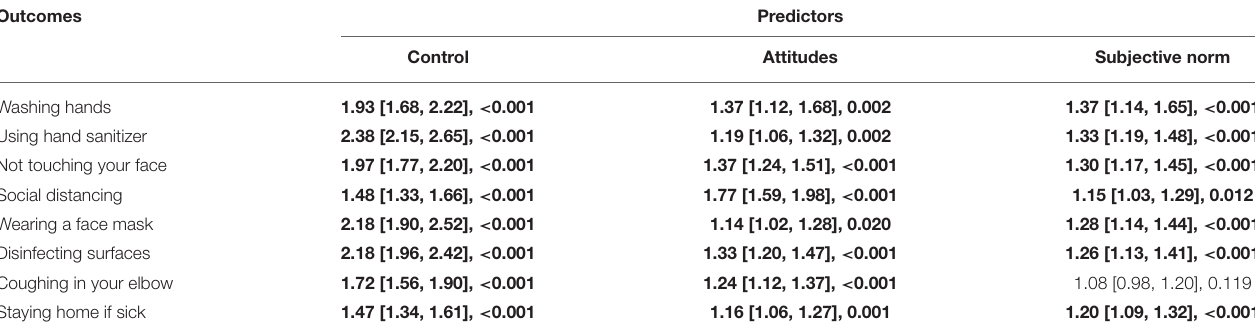
TABLE 2 | Logistic regressions predicting preventive behavior from perceived behavioral control, attitudes, and subjective norm of that